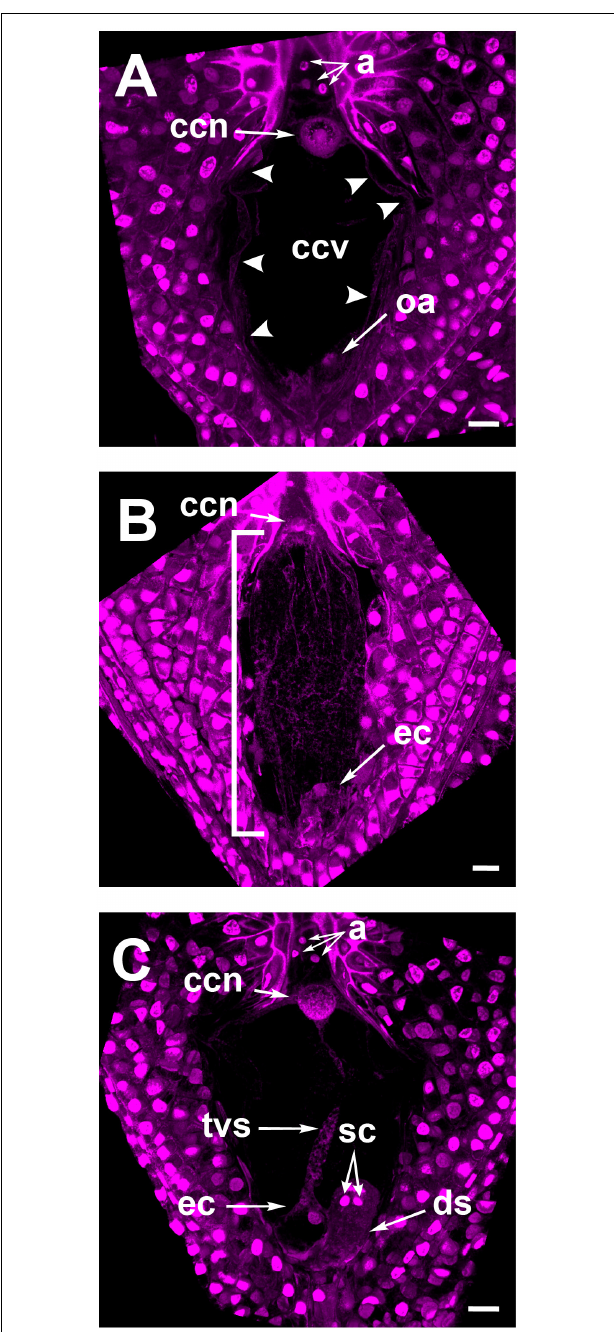
FIGURE 4 | Feulgen stained ovules of Agave inaequidens show the developmental specificity of the transvacuolar strand. (A) Mature embryo sac at 1–18 HAP. (B) Embryo sac at 32–36 HAP. (C) Detection of the transvacuolar strand at 38–42 HAP. The two sperm nuclei remain at the chalazal end of the receptive synergid after their discharge but before karyogamy with central and egg cells occurs. a, antipodal cells; ccn, central cell nucleus; ccv, central cell vacuole; oa, ovular apparatus; ec, egg cell; tvs, transvacuolar strand; sc, sperm cells; ds, degenerating synergid. The bracket indicates the accumulation of longitudinal cytoplasmic strands. All micrographs are z-stack projections oriented with the chalazal pole at the top. Bar in (A–C) = 20 µ